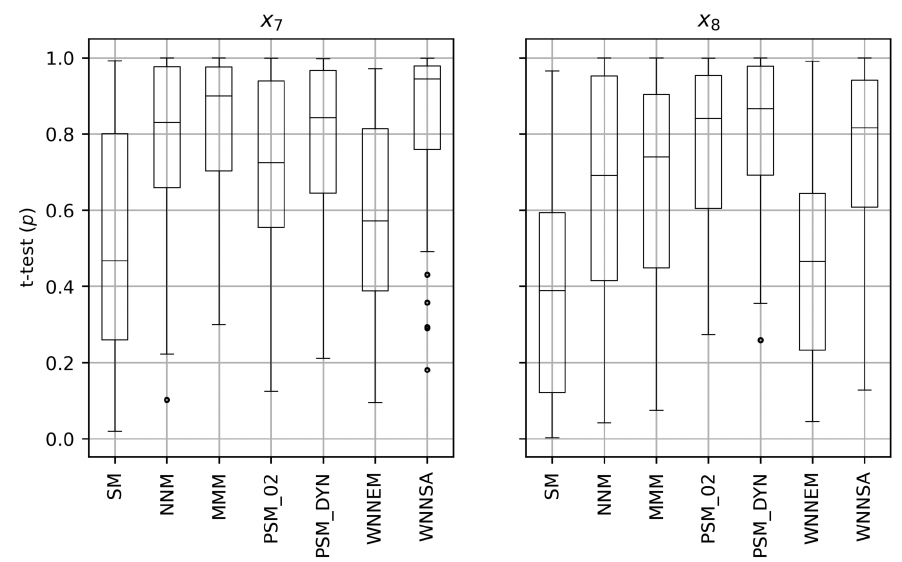
Figure 5. Distribution of continuous covariates in Scenario II. Distribution of the t -test p -values calculated for each covariate separately based on all simulations in Scenario II.